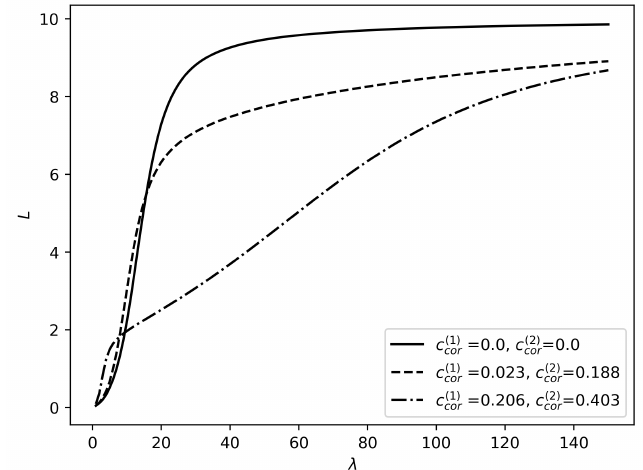
Figure 7. The mean number of customers in the buffer, L , as a function of the input rate λ for the BMMAP s with different coefficients of correlation.